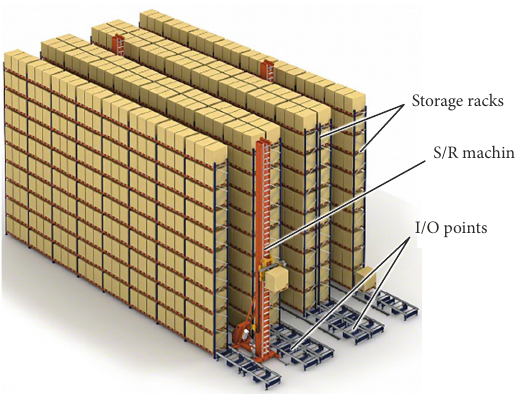
Figure 1. Unit load AS/RS illustration